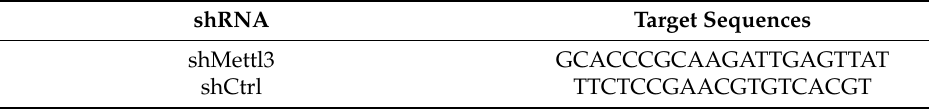
Table 1. Target sequences of shRNA.